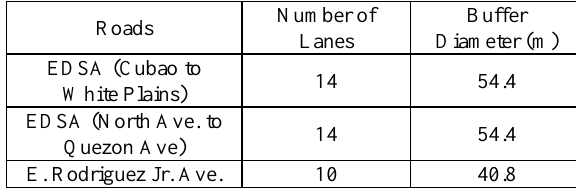
Table 1. Number of Lanes and Buffer Diameter Values of Road